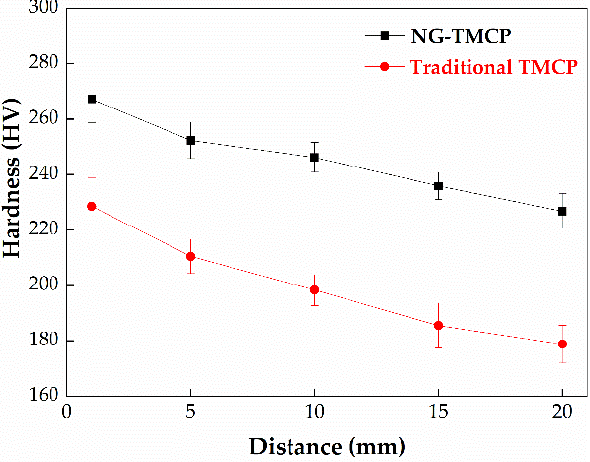
Figure 4. Vickers hardness evolution from the surface to the center